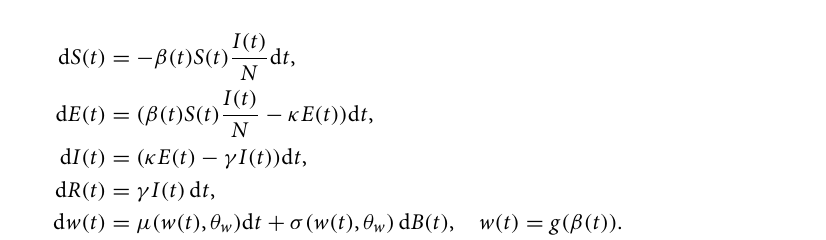
Figure 6. Estimates of the COVID-19 transmission rate for New York based on the typical SEIR model with constant reporting rate ( a ) and based on our SEIR model with a time-varying reporting rate p t ( b ). Solid lines, light-shaded and dark-shaded areas correspond to posterior means, 75% and 95% credible intervals of the associated transmission